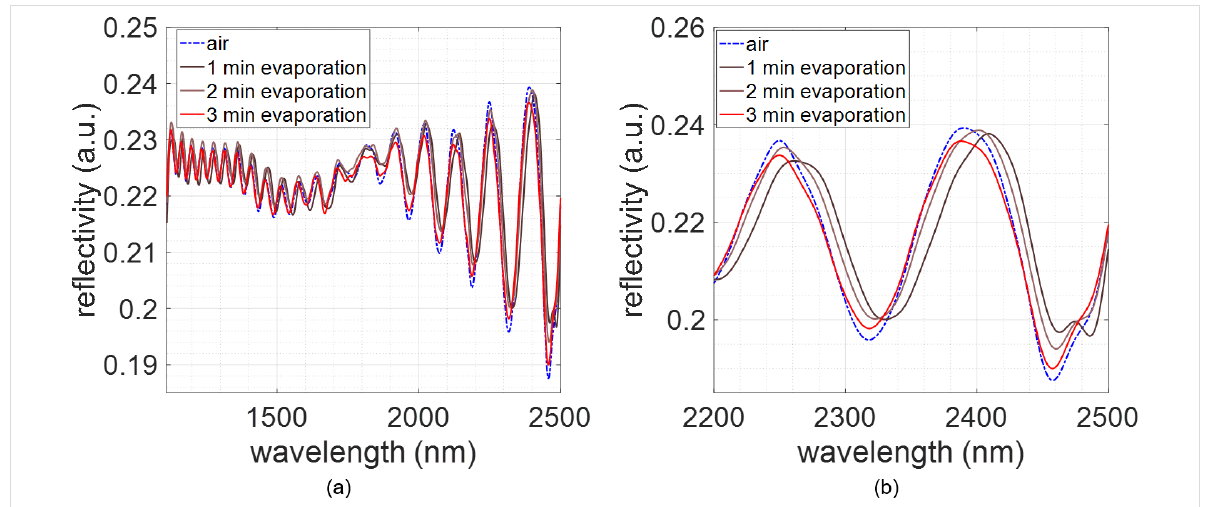
Figure 4: Evolution of the reflectivity spectrum of the PCTE membrane when placing a 50% ethanol solution on it. (a) For the whole characterization range (between 1110 and 2500 nm). (b) Detail of the spectral region between 2200 and 2500 nm.